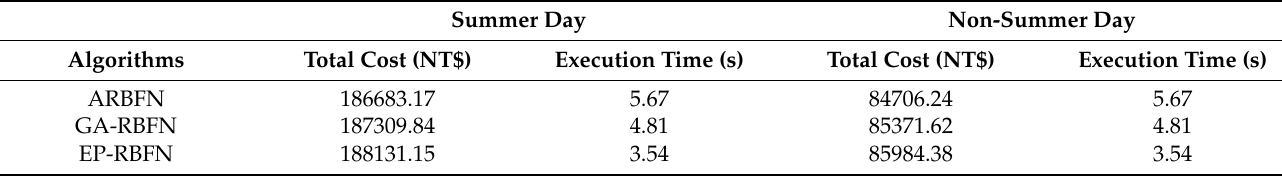
Table 6. Comparison of the various algorithms.